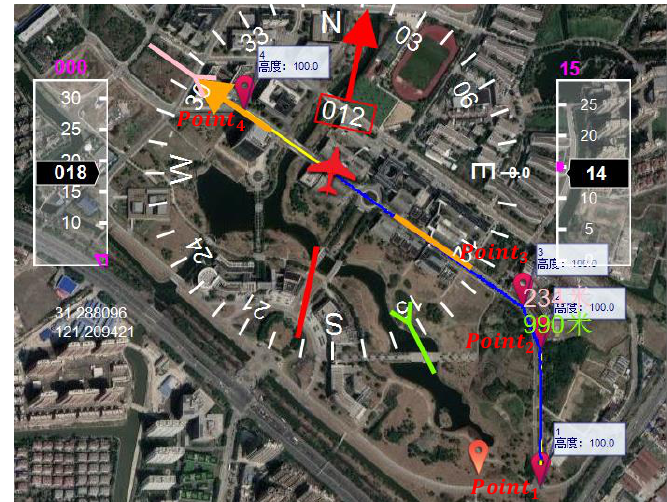
Figure 11. Presentation of the studied path and hardware in experiments. ( a ) Experiments path in Tongji University-Jiading Campus. ( b ) The UAV employed with a Pixhawk autopilot system. ( c ) The Pixhawk autopilot system deployed on a bicycle.